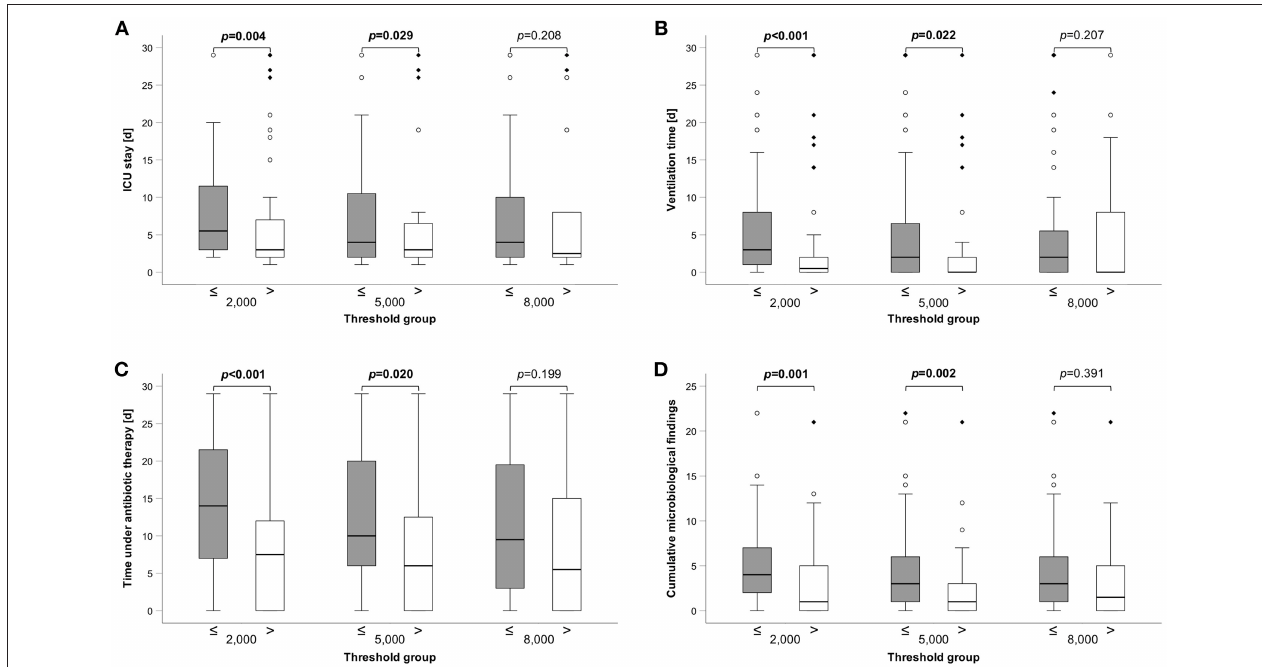
FIGURE 3 | Group comparisons of clinical variables between different HLA-DR thresholds. (A) Length of ICU stay, (B) Ventilation time, (C) Time under antibiotic therapy (all 3 in days), and (D) Cumulative microbiological findings are shown. A total of 110 patients has been analyzed. Box edges represent quartiles with median given as horizontal line within, whiskers span the 95% confidence interval. Open circles and diamonds indicate outliers. Group comparisons were performed by Mann-Whitney U -test and p -values are given above the compared groups. Bold type indicates a p ≤ 0.05, assumed as